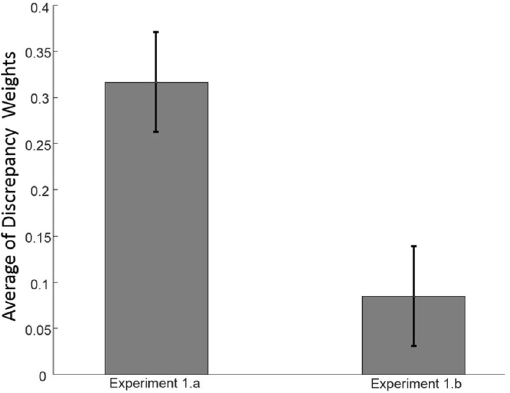
Figure 5. Discrepancy Weights. The discrepancy weights depend on the relative reliability of the cues across the different reliability conditions. Discrepancy weights are inversely correlated to the probability of the common cause P C . Thus, the lower discrepancy weight in the experiment 1.b indicates a higher probability of an assumed common cause, which is consistent with the observed behavior in that experiment. In contrast, the higher discrepancy weight in the experiment 1.a points to a lower common cause probability that explains the selection strategy in experiment